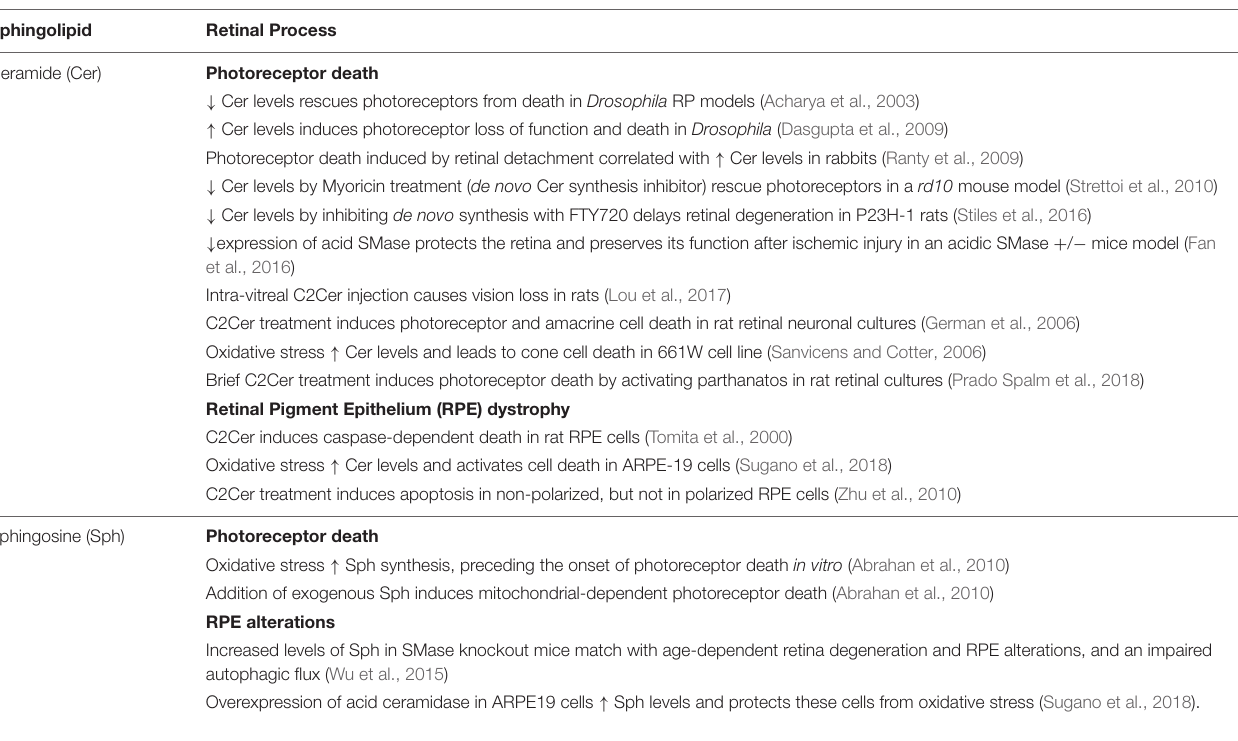
TABLE 1 | Ceramide and sphingosine functions in the